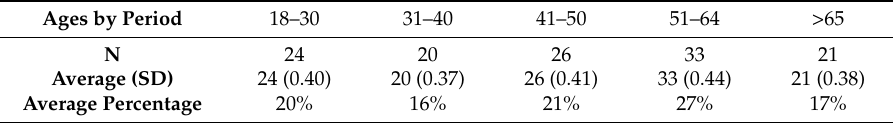
Table 2. Characteristics of the sample subdivided by specific periods.